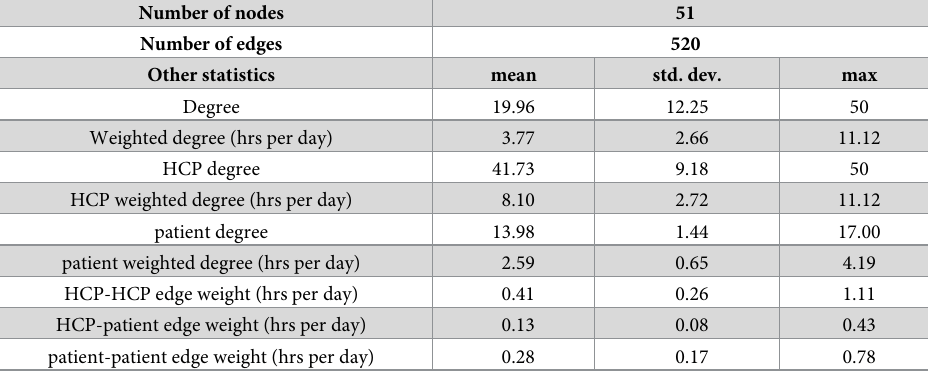
Table 2. Network statistics of static graph G . Number of nodes 51 Number of edges 520 Other statistics